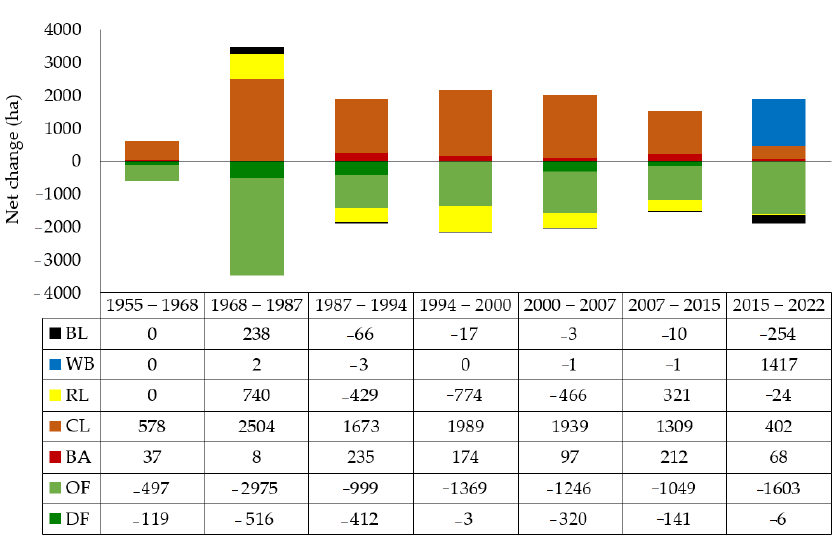
pattern of net changes from dense and open forests to other land uses/covers demon- strates that before the FNL (1955 –1968), −119 and −498 ha of these classes’ changes were conversion to croplands. During the same period, only +1 ha of barren lands was con- verted to open forests. Results showed that after implementation of the FNL, −1220 and −8132 ha of dense and open forests, respectively, were converted to croplands. An increase in open forests occurred by +24 and +134 ha in the periods of 1968 – 1987 and 2007 – 2015, Land use/cover classes: DF—dense forest, OF—open forest, BA—built-up areas, CL—croplands, RL—rangelands, respectively, by conversion from dense forests. WB—waterbodies, and BL—barren lands.